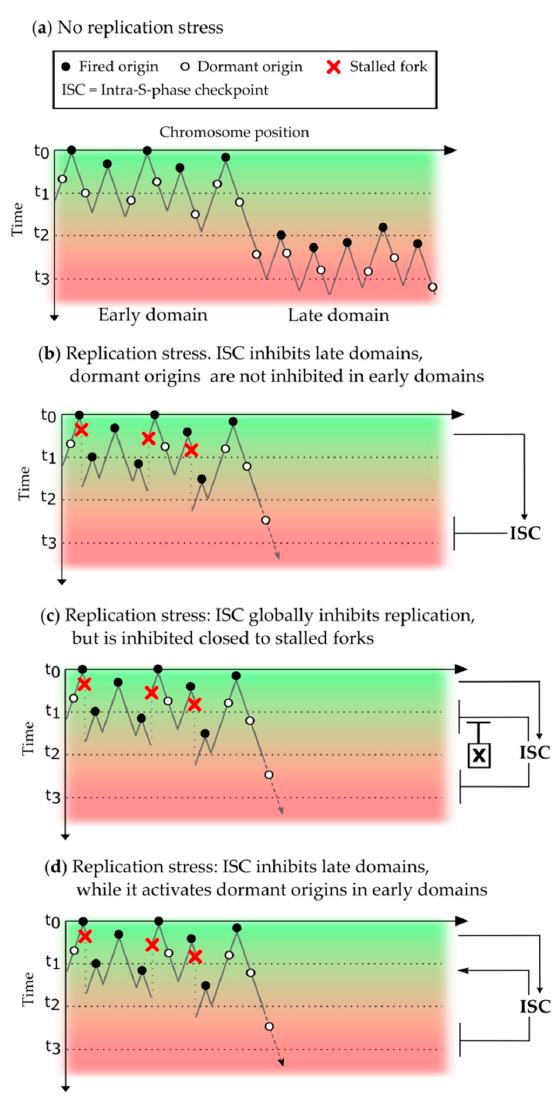
Figure 1. Models of the regulation of the spatio-temporal replication program by the intra-S phase checkpoint. The “ y -axis” represents the S phase time, where t 0 is the start of S phase and t 1 < t 2 < t 3 are three subsequent arbitrary times smaller than the duration of S phase. The “ x -axis” is the chromosomic position. Black lines symbolize replicated DNA, and valleys represent terminations. ( a ) In the absence of replication stress, replication origins fire in early domains (green region) or late domains (red region). In the presence of replication stress, the intra S phase checkpoint (ISC) inhibits origin activation in late domains and three different models are proposed to explain the firing of dormant origins inside early domains: ( b ) The ISC passively allows dormant origins firing close to stalled forks. Due to a slight asynchrony between early and dormant origins in early domains, pre-initiation complexes (preICs) on dormant origins might have passed the ISC inhibited steps, ( c ) ISC action is inhibited inside early domains by an unknown mechanism X, maybe by Plk1 interaction with MCM2-7 [71] closed to stalled forks, and ( d ) ISC locally activates dormant origins inside early domains by an unknown mechanism.